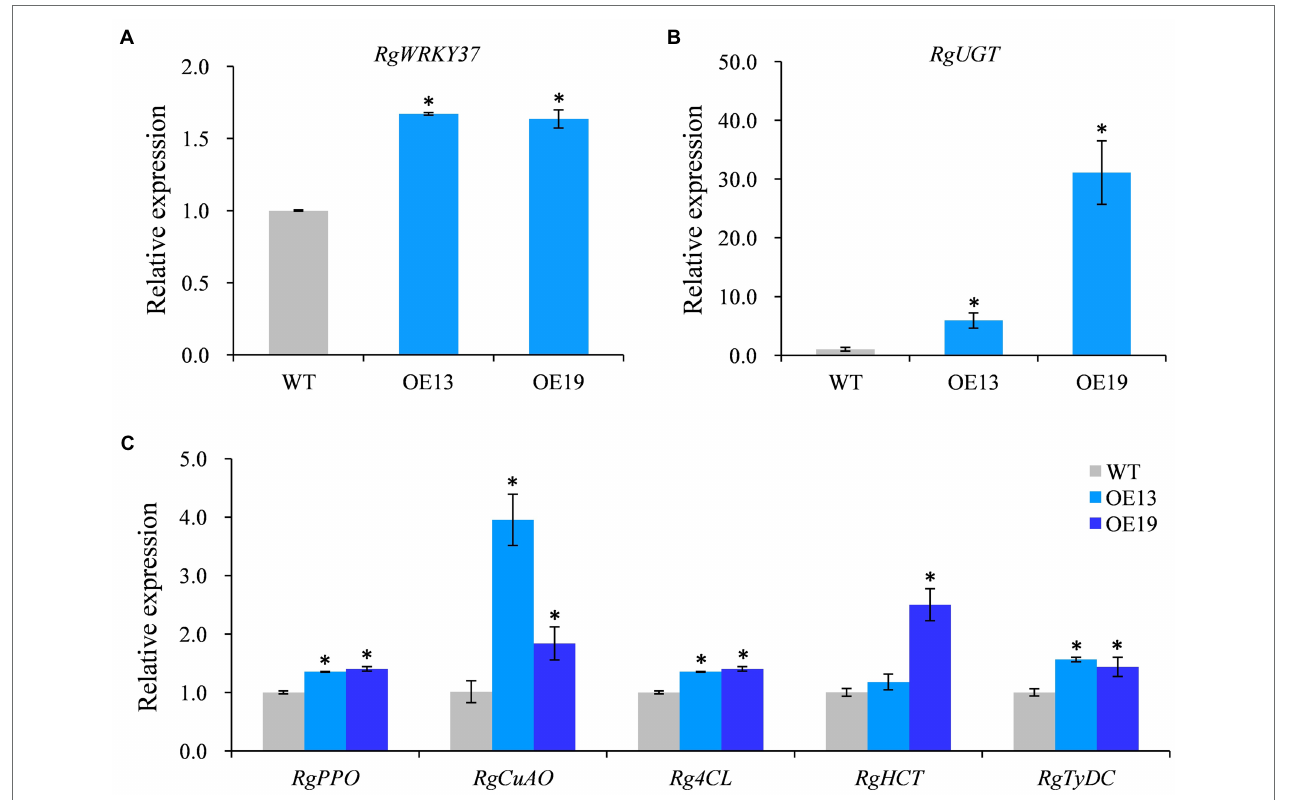
FIGURE 9 | Transcription levels of RgWRKY37 and the endogenous acteoside biosynthesis genes in hairy roots of transgenic lines. (A) Relative expression levels of RgWRKY37 in transgenic hairy roots. (B, C) Relative expression levels of acteoside biosynthetic genes in transgenic hairy roots. The vertical bars show the SD values ( n = 3). The asterisks indicate statistically significant differences at p <